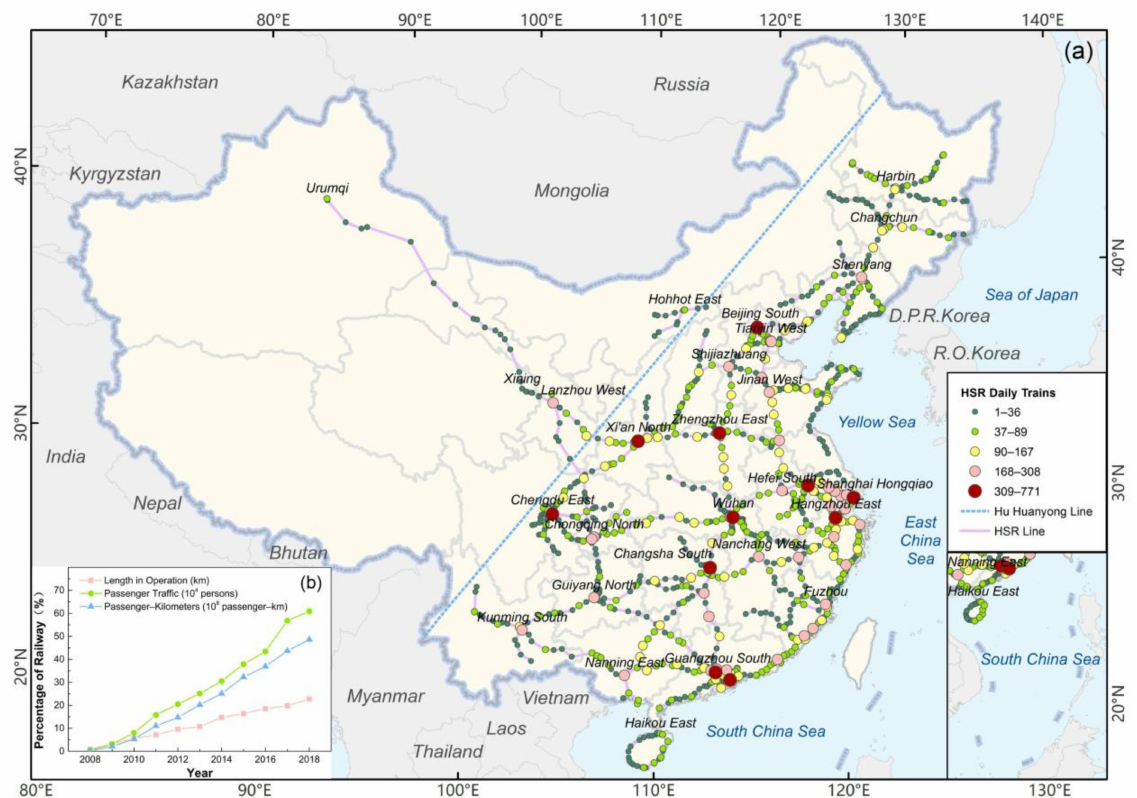
Figure 1. Study area and high-speed rail (HSR) development. ( a ) Study area with HSR lines, stations, and daily trains in 2019. ( b ) HSR development from 2008 to